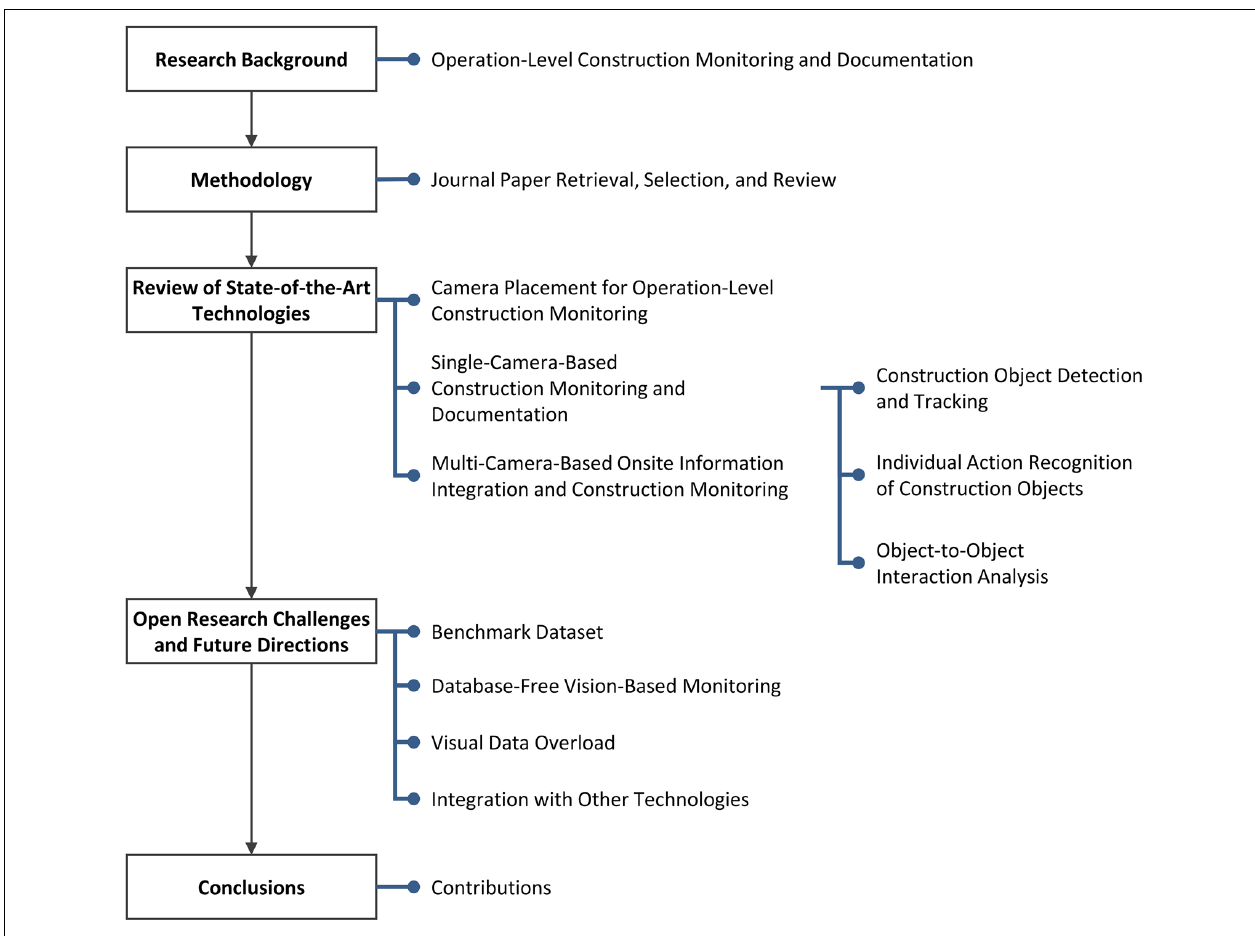
FIGURE 1 | Organization of this